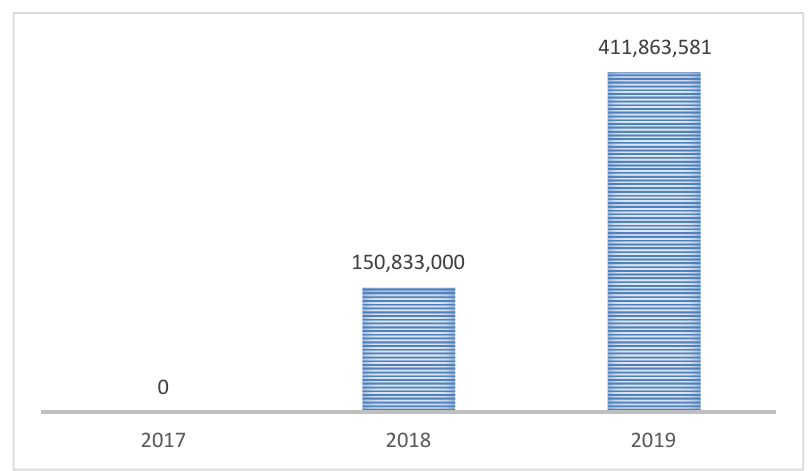
Figure 4. Local community income in 2017–2019 in target area (IDR: Indonesian Rupiah).